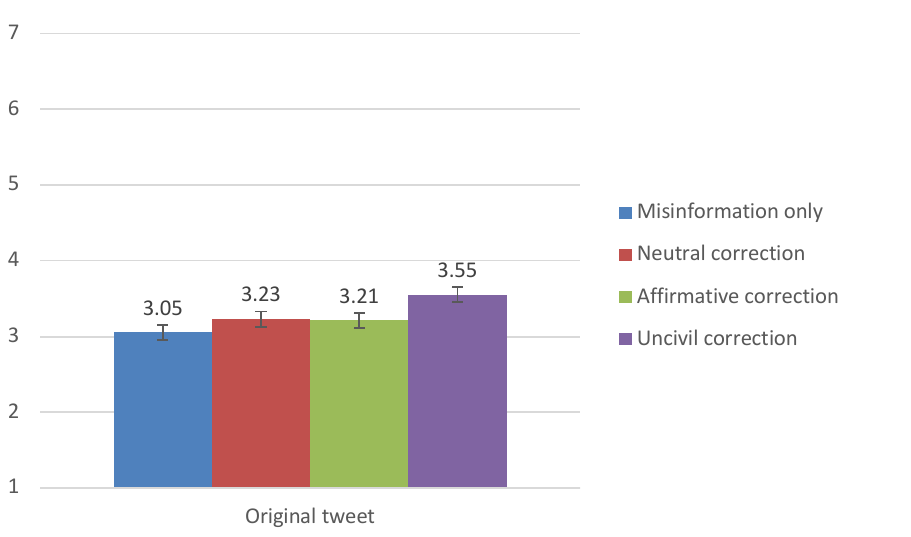
Figure 4. Perceptions of Original Tweet Incivility by Experimental Condition. Note that higher numbers reflect greater perceptions of incivility. Each color shows the average for the group. Error bars represent a 95% confidence interval for the